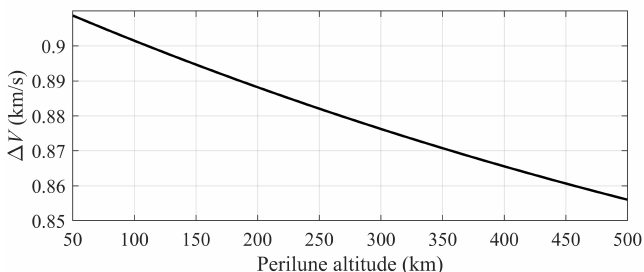
Figure 11. Relationship between velocity increment and perilune